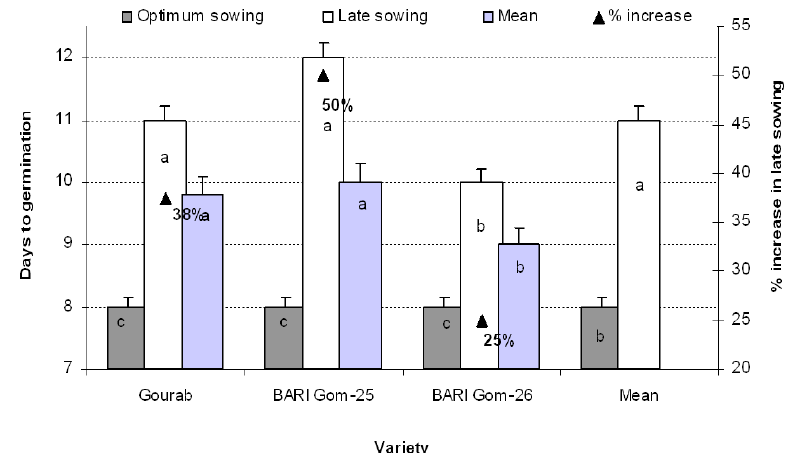
Fig. 2. Days passed to germination of 3 wheat varieties sown under optimum and very late conditions. Mean (±SD) was calculated from three replicates for each treat- ment. Bars with different letters are significantly different at p ≤0.05 (LSD test)